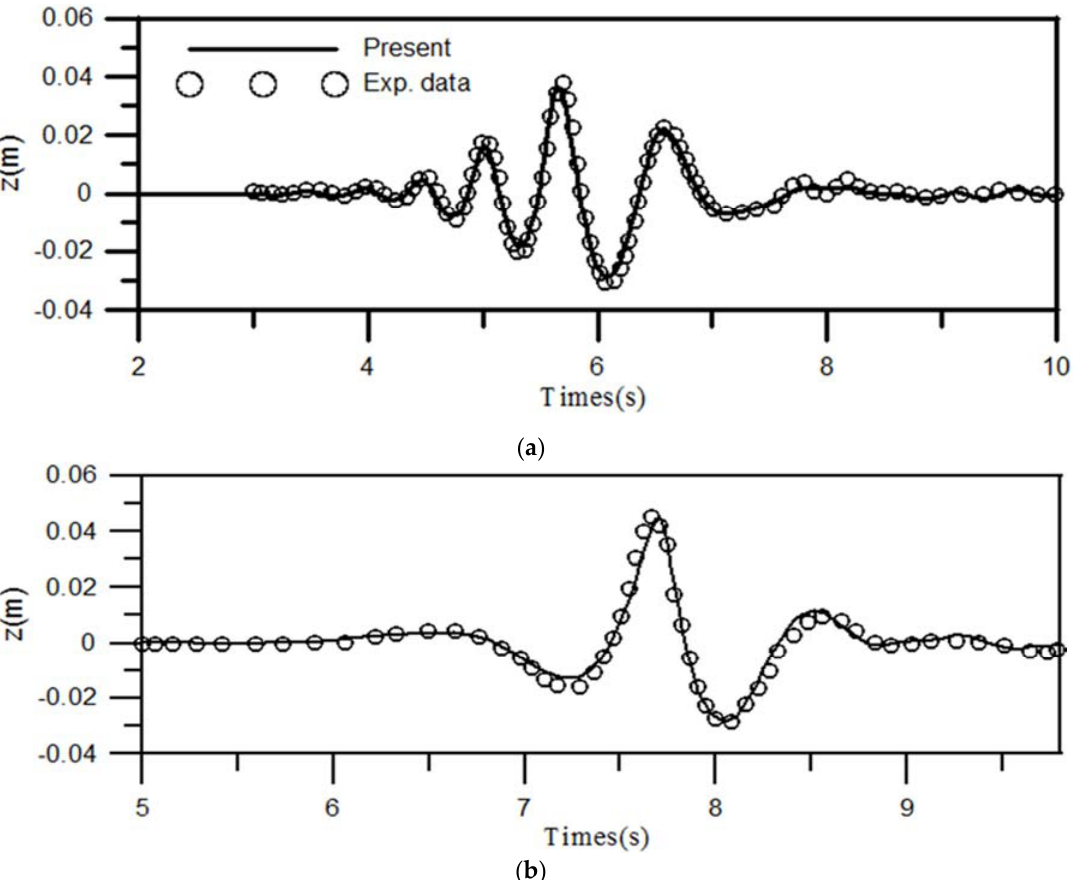
Figure 22. Time ‐ based variations of wave elevation during the evolution of the wave packet at ( a ) x = 1.65 m and ( b ) x = 2.66 m.